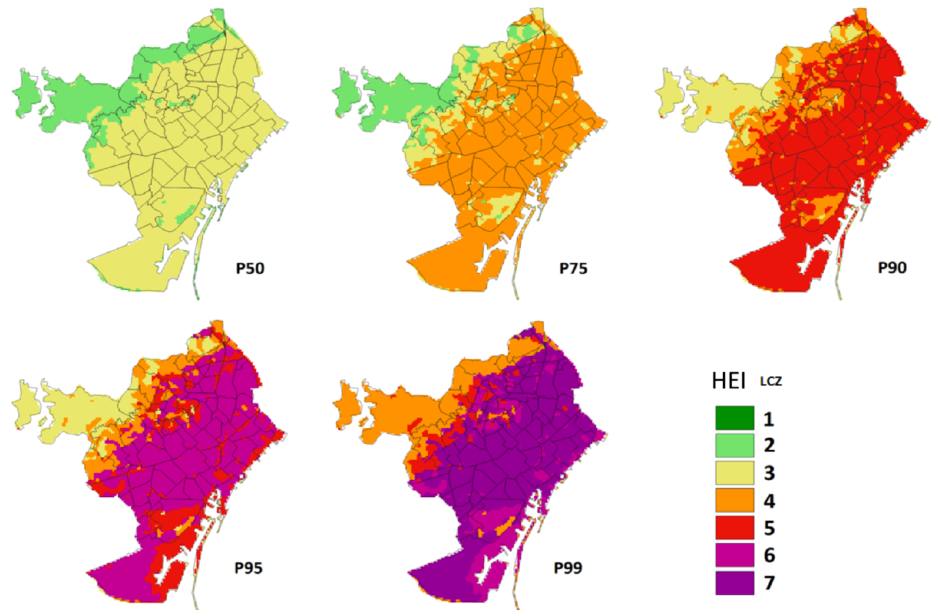
Figure 11. Cartography of the heat exposure index (HEI) in reference to thermal characterisation of Barcelona by LCZs for different per- centiles (LCZ– T ) as shown in Table